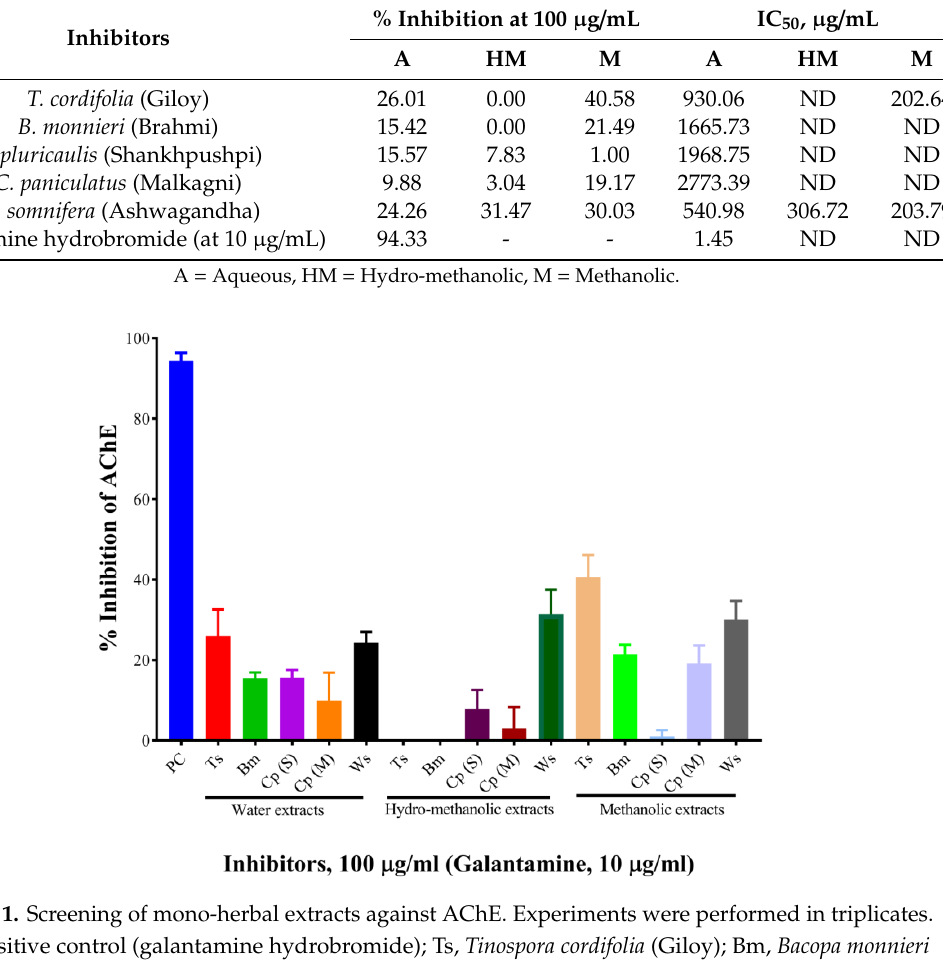
Table 1. Screening and IC 50 determination of herbal extracts against AChE.